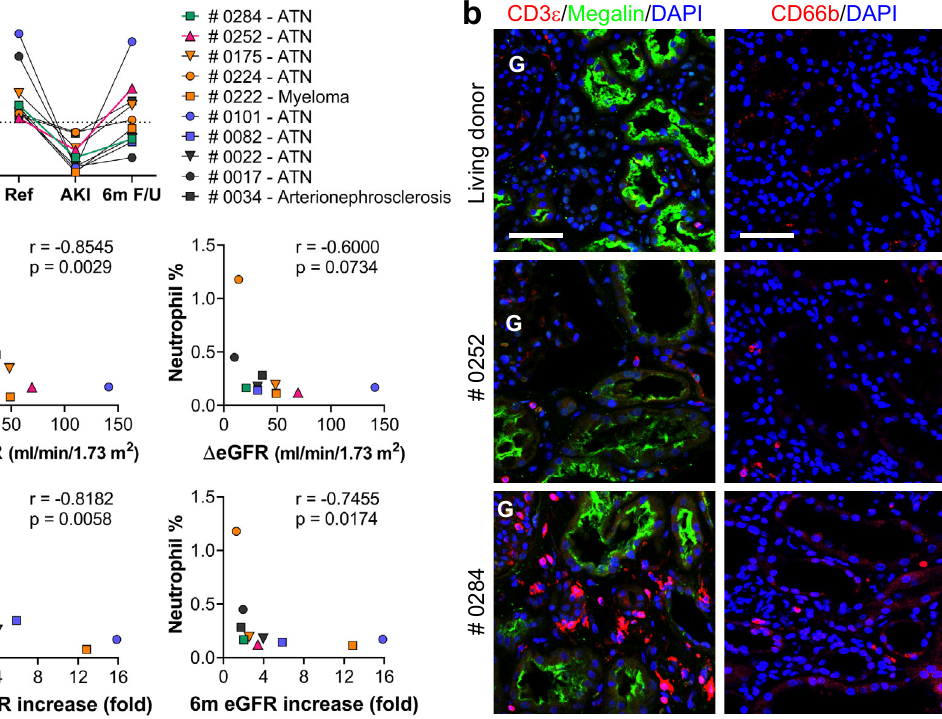
Fig. 10 | Accumulation of T cells and neutrophils negatively associates with GFR recovery in patients with AKI. a The estimated GFR (eGFR) was determined atreference,biopsy(AKI),and6-monthfollow-up(6mF/U). b Biopsysectionsfrom each patient wereimmuno fl uorescence-stainedwith anti-CD3 ε (T-cellmarker)and anti-megalin (PT marker, left panel) or anti-CD66b (PMN marker, right panel) and the percentage of nuclei positive for CD3 ε and CD66b calculated for all sections. Representative images of biopsies from a patient with full recovery [Case #0252, 150% recovery of GFR, magenta triangle in a ], low-recovery [Case #0284, 52%